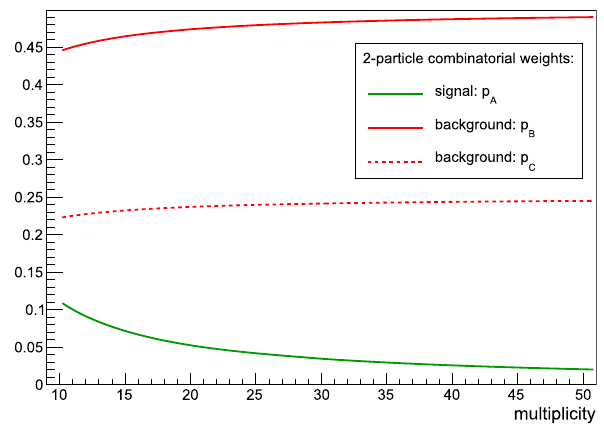
Fig. 2 Multiplicity dependence of three distinct combinatorial weights, p A , p B and p C (seethemaintextfortheirdefinitionsandexpla- nation), which always appear in two-particle correlations. The contri- bution from genuine two-particle correlations (signal) is weighted with p A (green line). For large M this contribution is suppressed when com- pared with two distinct contributions from a combinatorial background (red lines). The results from this figure cover any case in which particles are produced in pairs from the general two-variate p.d.f. f xy ( x , y )